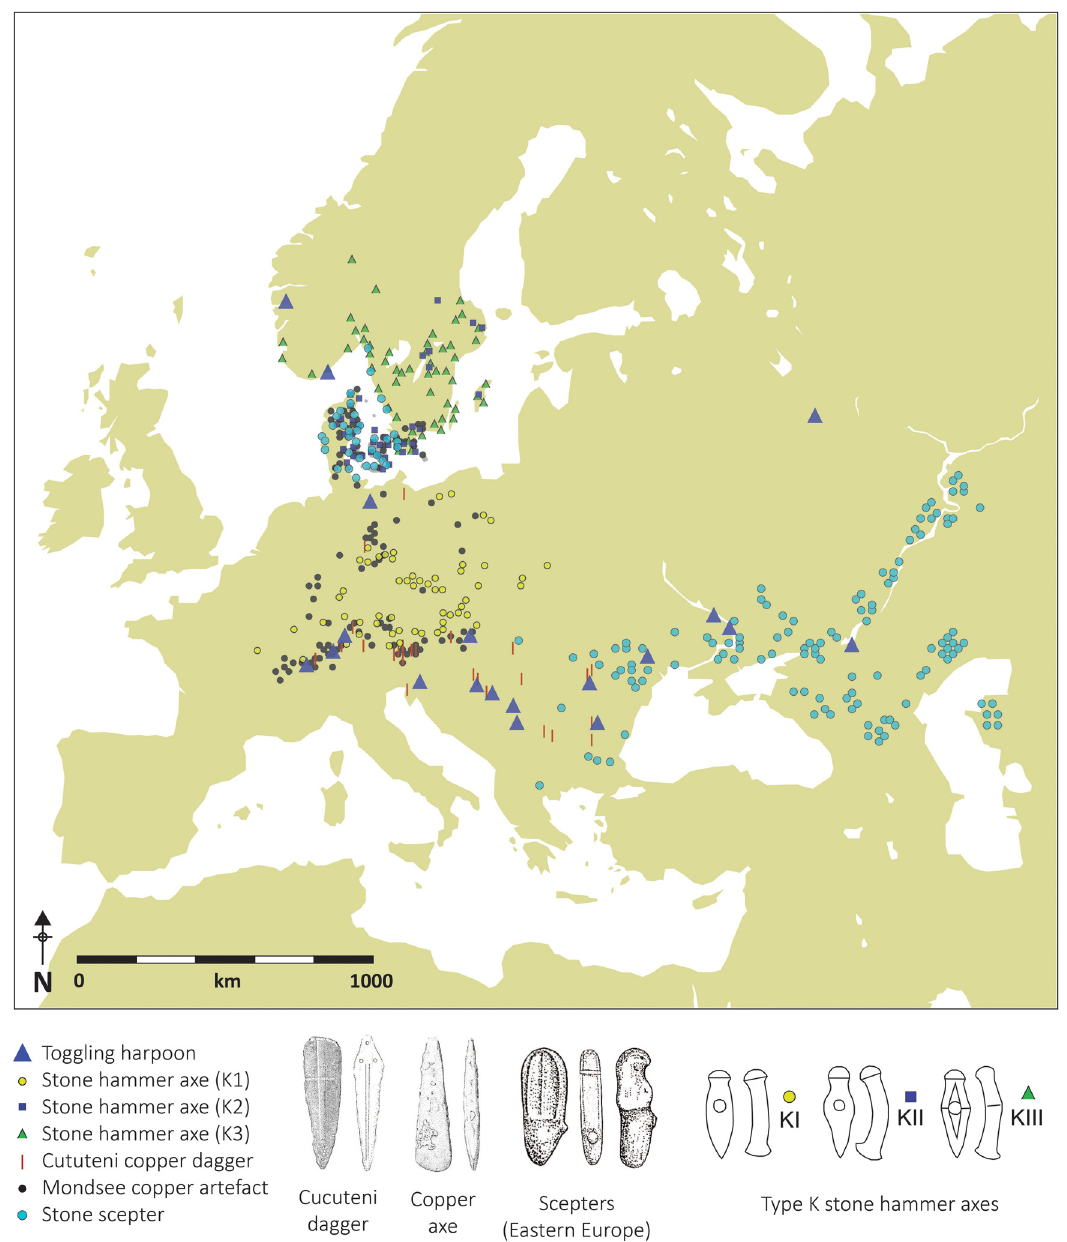
Figure 7: Distribution map of artefact types discussed in the article ( see legend ) . Battle - axes ( i.e. Stone hammer axes ) after Zápotocký ( 1992, pp. 529 – 531, Tafel 129 – 131 ) and Ebbesen ( 1998, p. 89, Figure 13 ) , copper artefacts after Klassen ( 2001, p. 63, Figure 9; 2014, pp. 229, 242, Figure 134 ) and Nielsen ( 2016, p. 160, Figure 7 ) . Stone sceptres after Dergachev ( 2000, pp. 307 – 308, Figure 15, Map 16 ) , Ebbesen ( 1988, pp. 11 – 13, Figures 5 – 7 ) , Glob ( 1952, Figures 83, 85, 87 ) , Hartz ( 2015 ) , and Hinsch ( 1955 ) . Note that example illustrations of artefacts are not shown with correct measurements. Figure by Svein V.